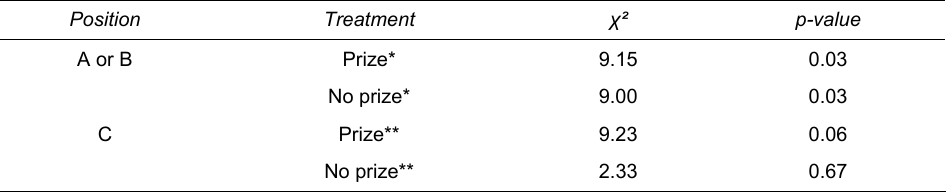
Table 4: Mann-Whitney U tests for differences over treatments implied by Figure 1 Position